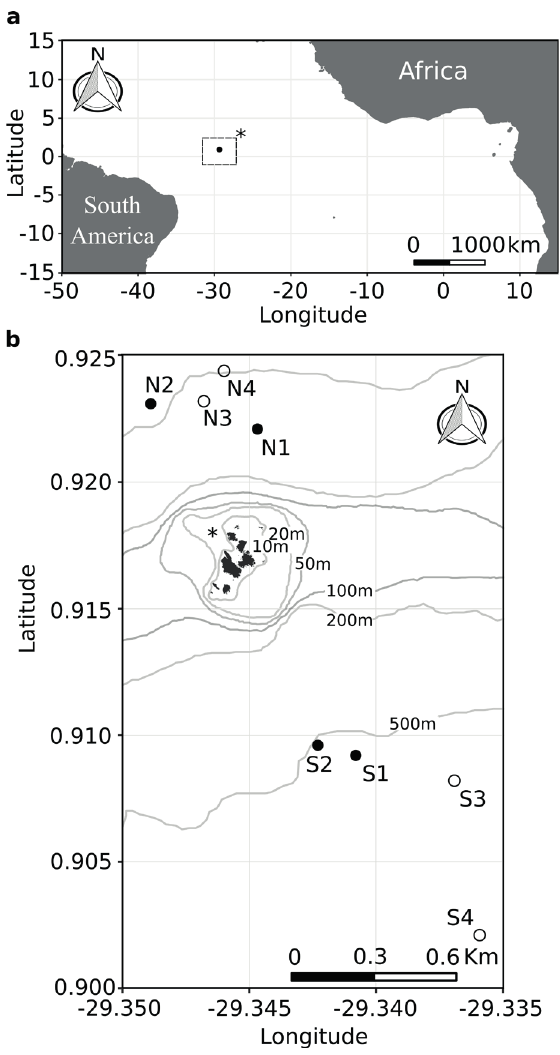
Figure 1 - Location of the ASPSP in the South Atlantic Ocean ( a ) and locations of the sampling sites around the archipelago ( b ). Filled circles represent the sites sampled in the period of maximum rainfall (April), and empty circles represent sites sampled during the period of minimum rainfall